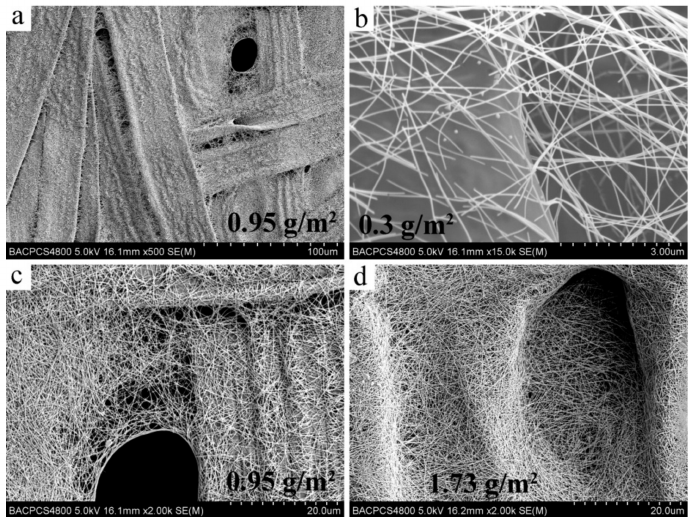
Figure 5. SEM images of the conductive papers with different AgNWs areal densities. ( a ) 0.95 g/m 2 , a large scaled view; ( b ) 0.3 g/m 2 ; ( c ) 0.95 g/m 2 , a small scaled view; ( d ) 1.73 g/m 2